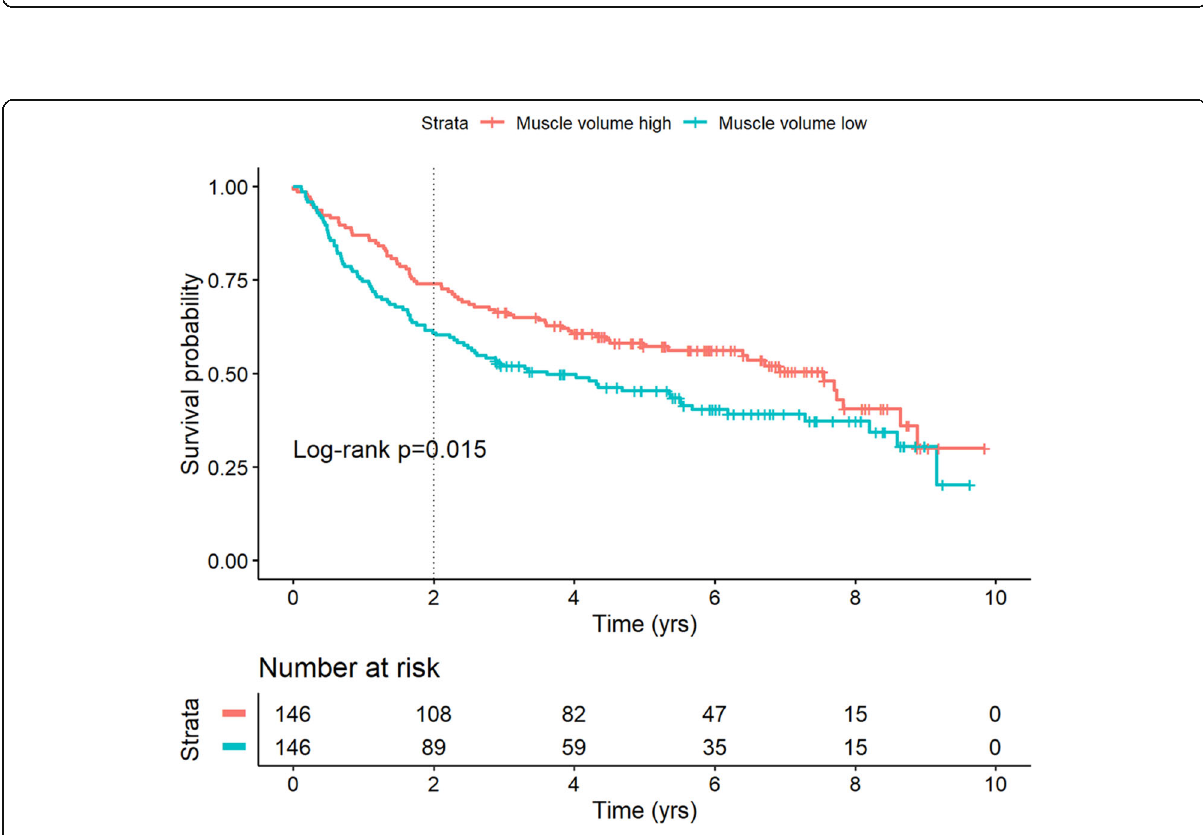
Fig. 3 Kaplan-Meier diagram of overall survival grouped by segmented muscle volume higher or lower than the median. Time in years after cystectomy. Log-rank test was done for 2-year restricted overall survival (dotted line), but the diagram shows that the initial difference in survival extends through at least the first 7 years of